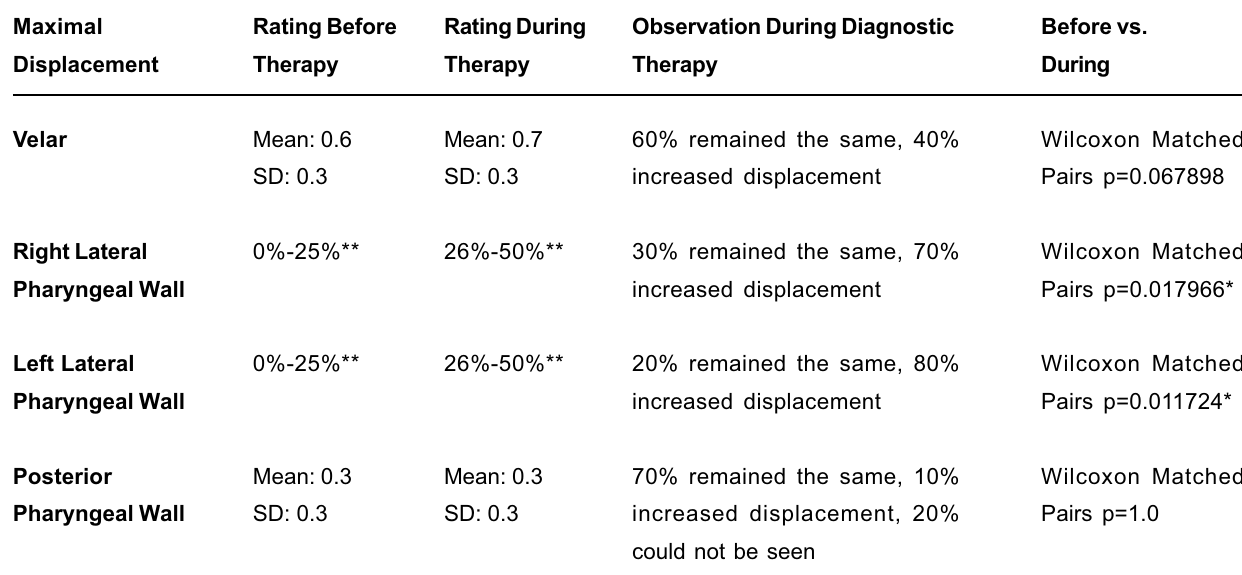
*Significant difference between displacement before and during diagnostic therapy ** Displacement rated in quarters (0%-25%, 26%-50%, 51%-75%, 76%-100%) instead the scale 0.0 to 1.0 SD= Standard